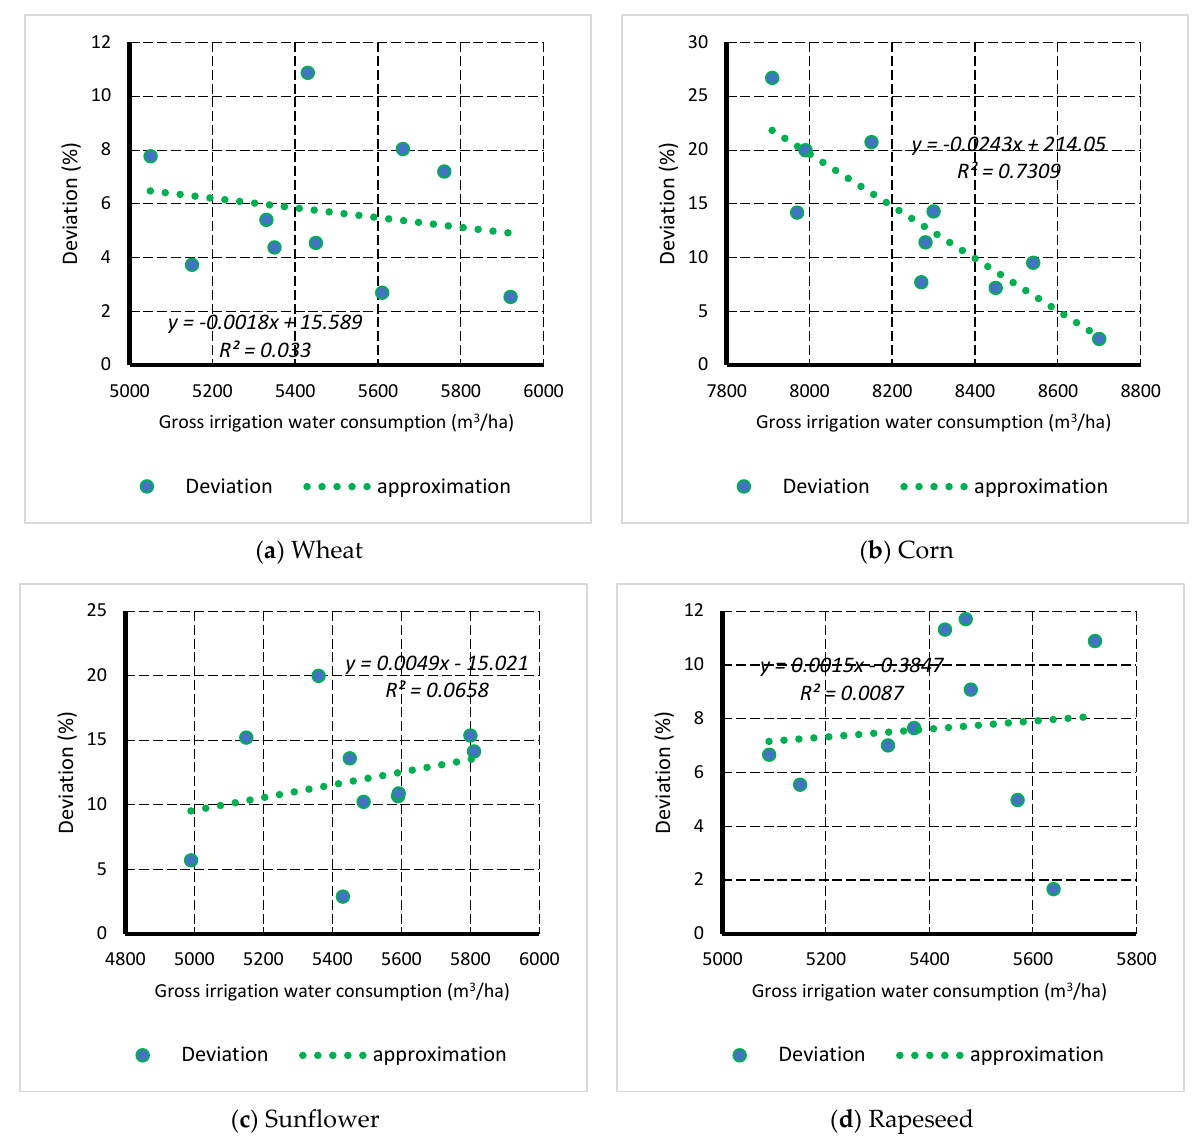
Figure 6. The relationship between the deviation of yield and gross water consumption.